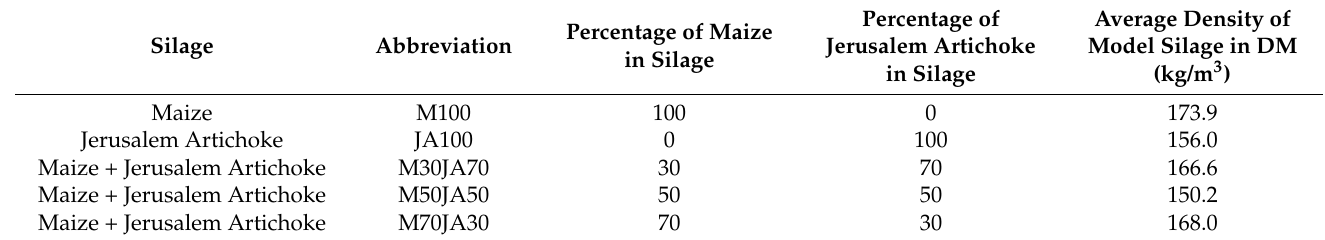
Table 2. Overview of the model silages